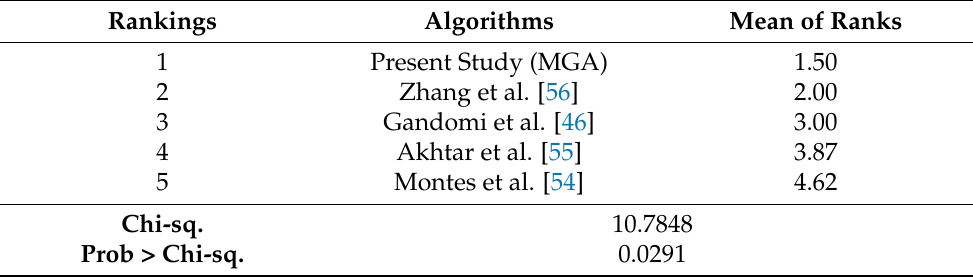
Table A2. Friedman statistical test results for the speed reducer design problem.